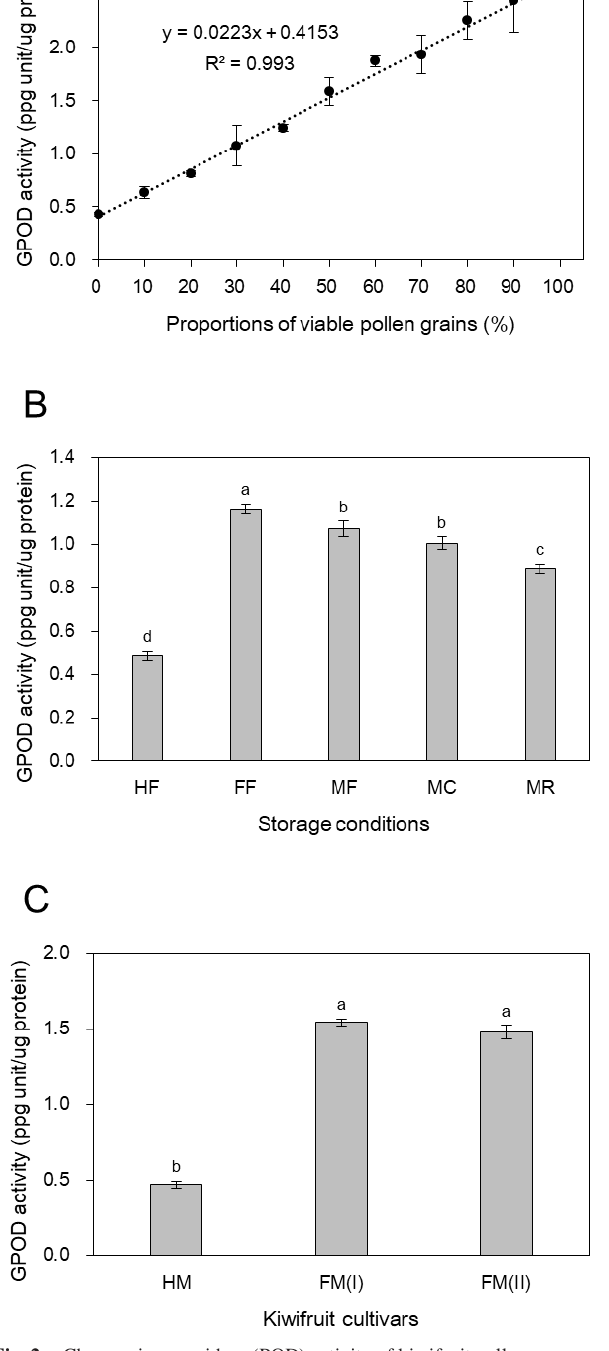
Fig. 2: Changes in peroxidase (POD) activity of kiwifruit pollen. The activity of POD was examined based on proportions of viable pollen grains (A), under different storage conditions (B), and be- tween kiwifruit cultivars (Matua I and II) (C). HF, heat-treated fro- zen storage; FF, fresh frozen storage; MF, moisture-treated frozen storage; MC, moisture-treated cold storage; MR, moisture-treated RT storage; HM, heat-treated Matua I; FM(I), fresh Matua I; FM(II), fresh Matua II. Different letters on error bars indicate significant differences based on Tukey’s Studentized range at p ≤ 0.05. Error bars represent the SE of mean values ( n = 3).